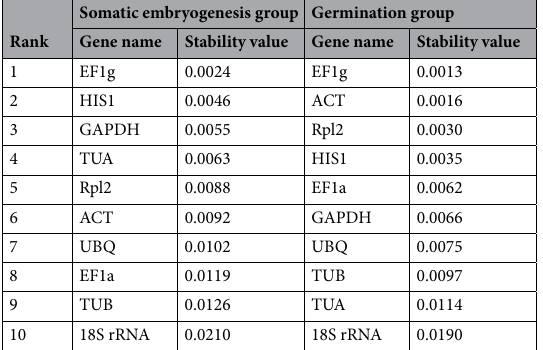
Table 1. Ranking of the candidate reference genes according to their stability value calculated by NormFinder. The input data for NormFinder are supposed to be on a linear scale. The raw Ct values were transformed to linear scale expression quantities using the standard curve or delta-Ct